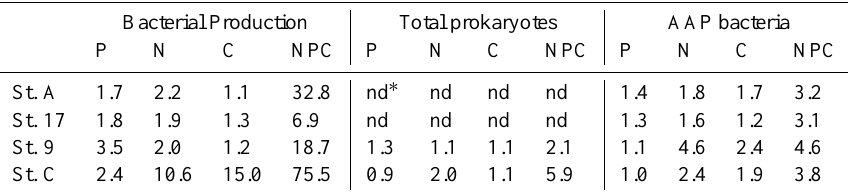
Table 2. Bacterial production, abundances of total prokaryotes and AAP bacteria after nutrient (P for phosphate, N for nitrogen, C for glucose and NPC for N+P+C) amendments of surface (5m depth) seawater samples at 4 stations (St.) of the BOUM transect. Results are expressed relative to the unamended controls.